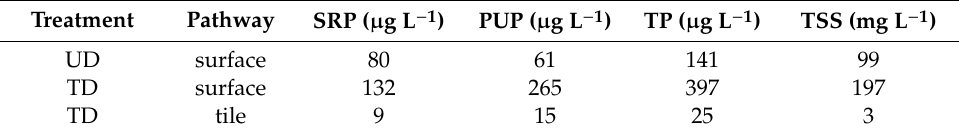
Table 3. Flow-weighted mean concentrations of soluble reactive phosphorus (SRP), particulate / unreactive phosphorus (PUP), total phosphorus (TP), and total suspended solids (TSS) by runo ff pathway in tile-drained (TD) and undrained (UD)